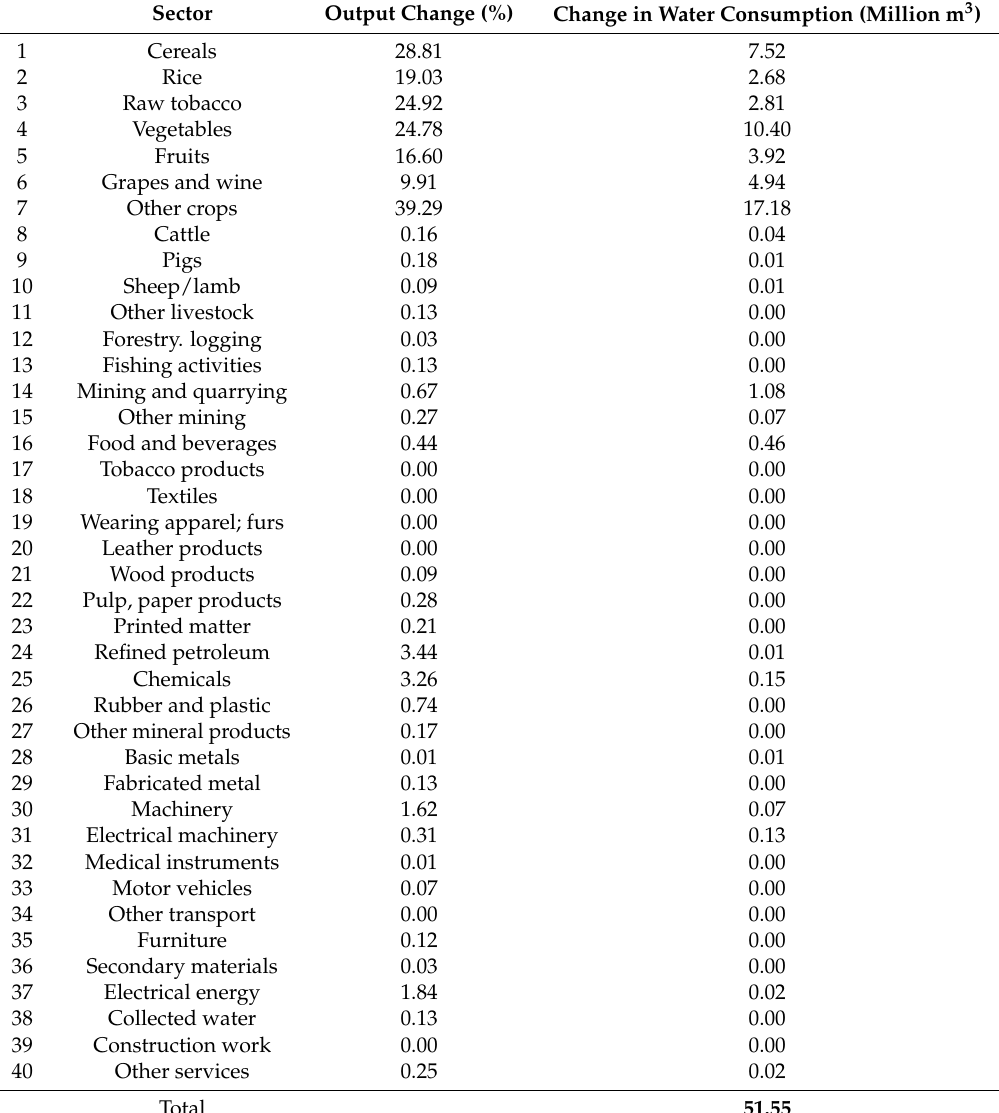
Table 6. Impacts of capital investment in irrigation equipment on agriculture sub-sectors and other sectors of the Macedonian